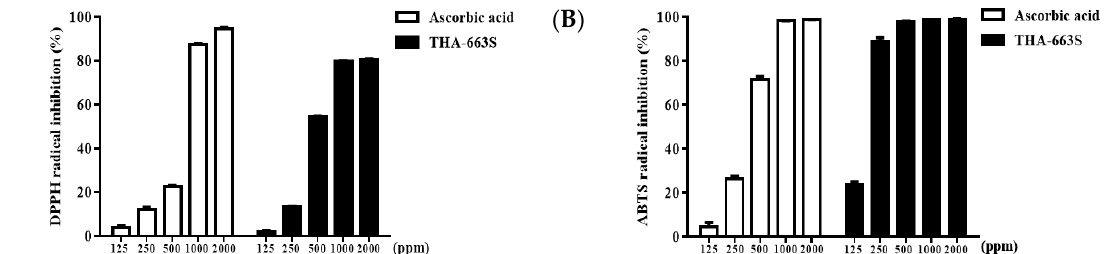
Figure 2. DPPH and ABTS radical scavenging activity of THA-663S. DPPH radical ( A ) and ABTS+ cation ( B ) scavenging activity of THA-663S. The radical scavenging effect was presented as a percentage measured in the control group. Ascorbic acid serves as a positive control. IC 50 values measured for ascorbic acid scavenging activity on DPPH and ABTS radicals were 521.2 and 160.5 ppm, respectively. The results are shown as the mean ± SD of three independent experiments.